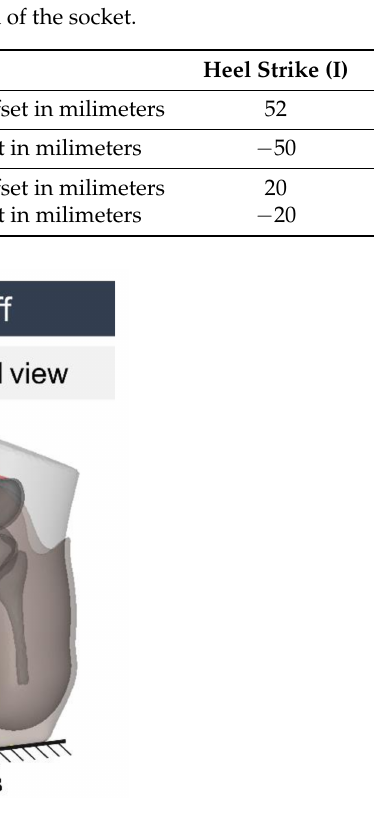
Figure 1. Overview of the load case for toe-off as defined in ISO 10328. ( A ) Frontal view of the model; the load is applied to the femur with a medial offset. ( B ) Sagittal view of the model; the load is applied with an anterior offset to the